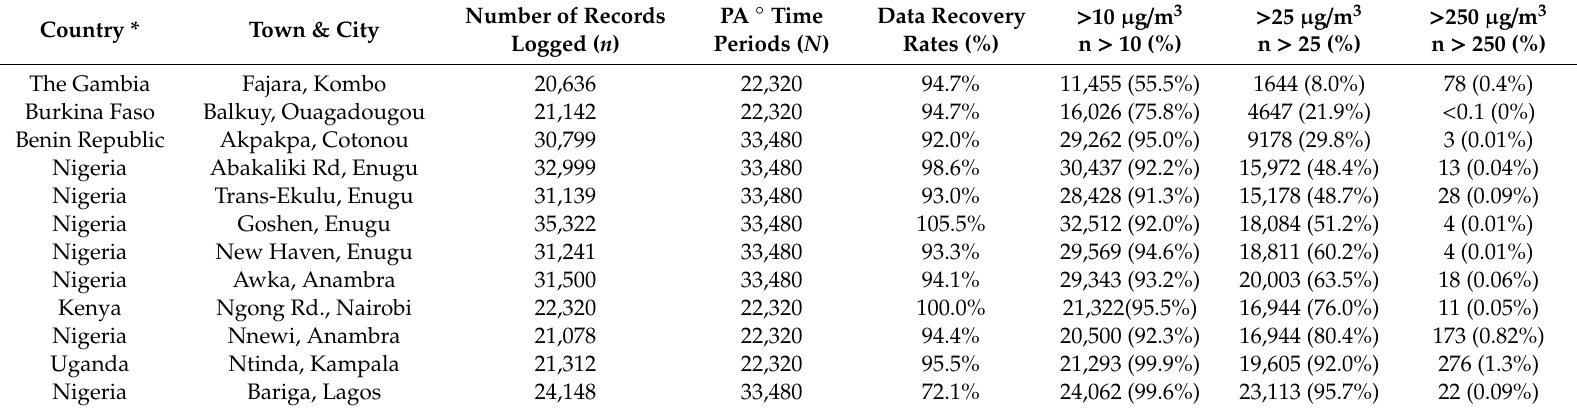
Table 2. Data Recovery Rates and Frequency Distribution of PM 2.5 Measurements by Three Di ff erent Threshold Categories by PA Time Periods in the MA3 Pilot Study. Country